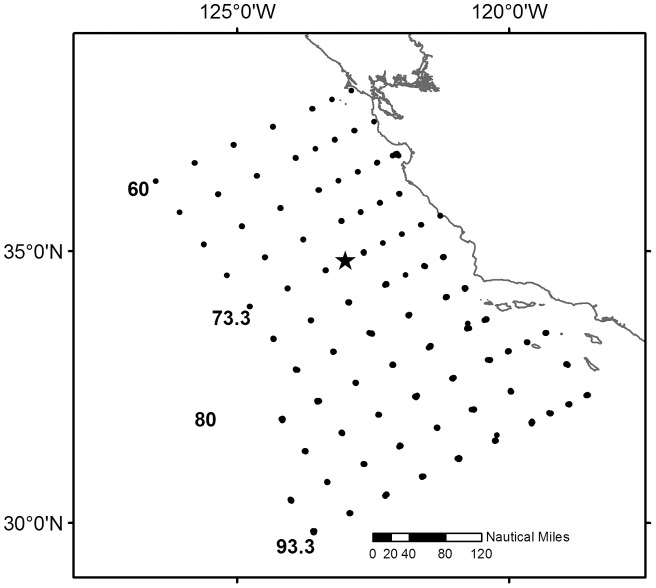
Stations used for analysis from the California Cooperative Fisheries Investigation (CalCOFI) fish egg surveys.The California coastline is depicted from San Diego in the south to San Francisco to the north. Several of the sampling line numbers are shown for reference. Station M is shown by the star.